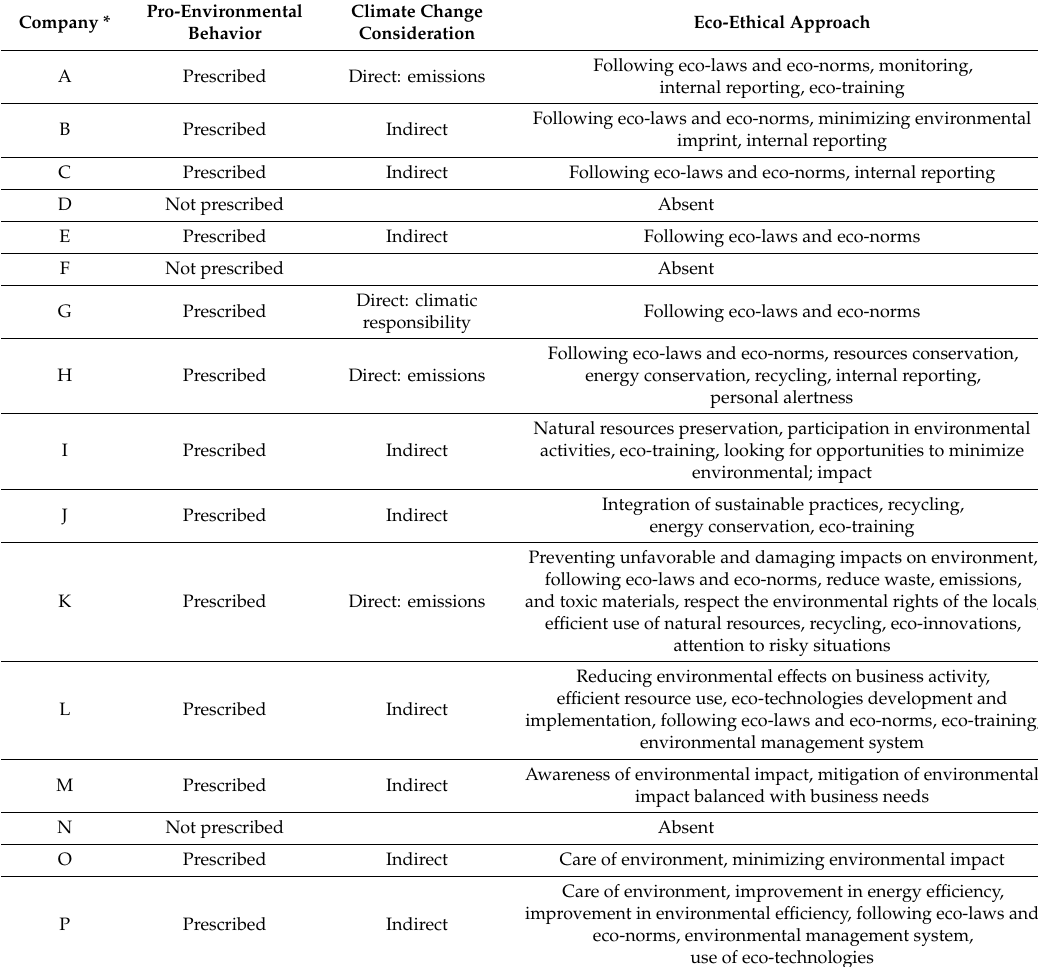
Table 2. Climate-friendly behavior recommended by the considered airline